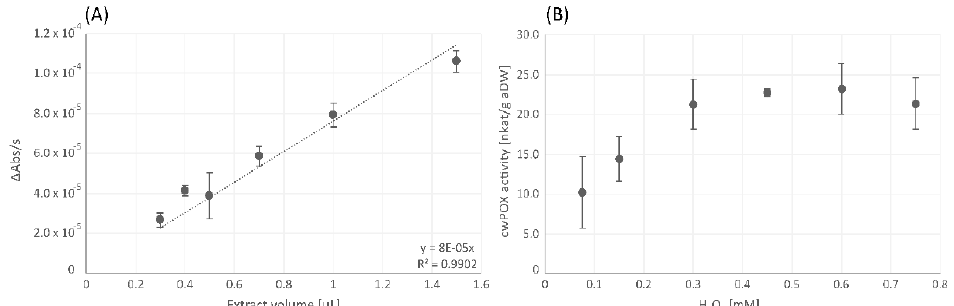
Figure 6. Extract-dependent linearity of cell-wall bound peroxidase (cwPOX) assay, performed with the original substrate concentration of 0.15 mM according to Fimognari et al. [43] ( A ) and variation of substrate (H 2 O 2 ) concentrations for cell wall-bound peroxidase (cwPOX) assay ( B ). Changes in absorbance per second [ΔAbs/s] ( A ) and cwPOX activity [nkat/g aDW] ( B ) are shown as mean values ± standard deviation (n = 3).